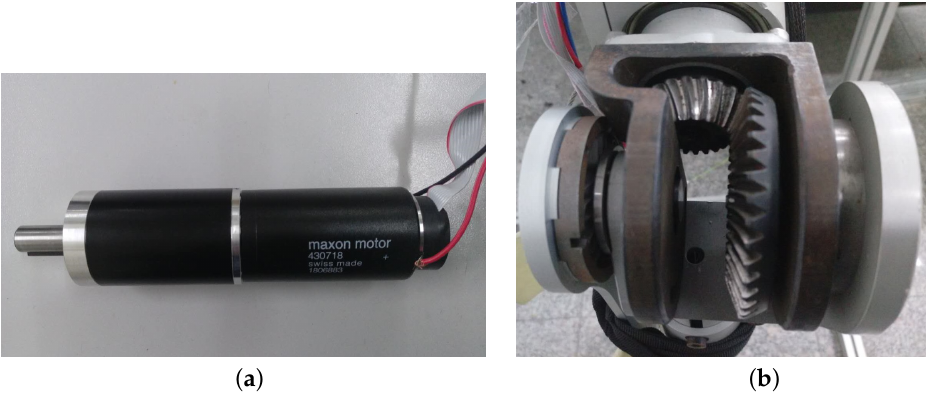
Figure 3. Mechanism of joint power transmission. Considering the scope of the joint torque and compactness of the mechanism, we chose the above scenario (i.e., electric motor with spur gearhead and bevel gears). ( a ) Electric motor RE40 and spur gearhead (26:1); ( b ) bevel gears